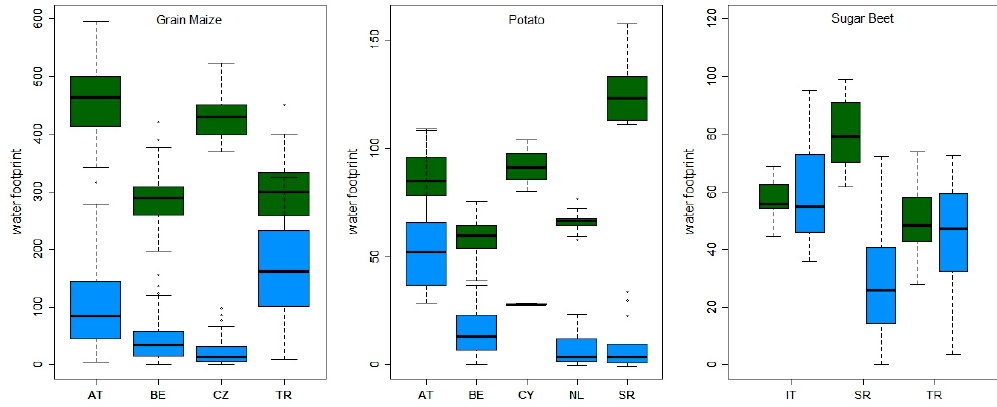
Figure 11. The blue water footprint (in m 3 ∙ Mg − 1 ) for modelled yields of irrigated arable crops across the European regions for the period 1992–2012. A two letter code refers to the country that the region belongs to.